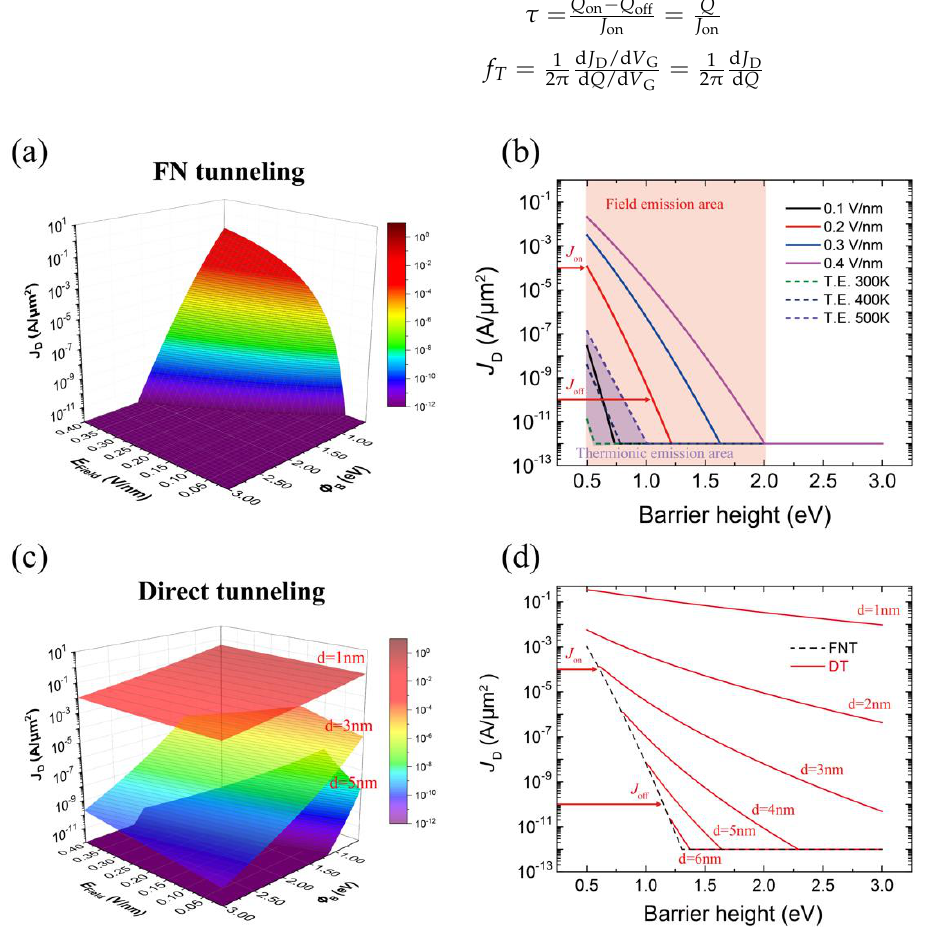
Figure 3. The simulated FNT current as a function of the tunneling barrier height and drain electric field. ( a ) A 3D plot of the FNT equation. ( b ) The channel current under a low drain electric field (0.1 V/nm) can be affected by the thermionic emission current. The ∆ J D / ∆ ∅ B ratios decreased with increasing drain electric field. The on-state current J on was 10 − 4 A/ µ m 2 when ∅ B was 0.5 eV, and the off-state current J off was 10 − 10 A/ µ m 2 when ∅ B was 1.055 eV. ( c ) A 3D plot of the DT equation for different thicknesses of the insulator. The DT current exponentially increased with a decrease in the thickness. ( d ) The simulated FNT current and DT as a function of the tunneling barrier height for different thicknesses of the insulator. The tunneling current under E Field = 0.2 V/nm was simulated by using the revised FNT and revised DT equations. The DT current increased with the decreasing thickness of the insulator. J on and J off indicate the on-state current and off-state current, respectively. We obtained a delay time τ of 0.18 ns and cut-off frequency f T of 3.98 GHz that were better than 1.1 ns and 1.3 GHz in the graphene/Si barristor. Therefore, when the